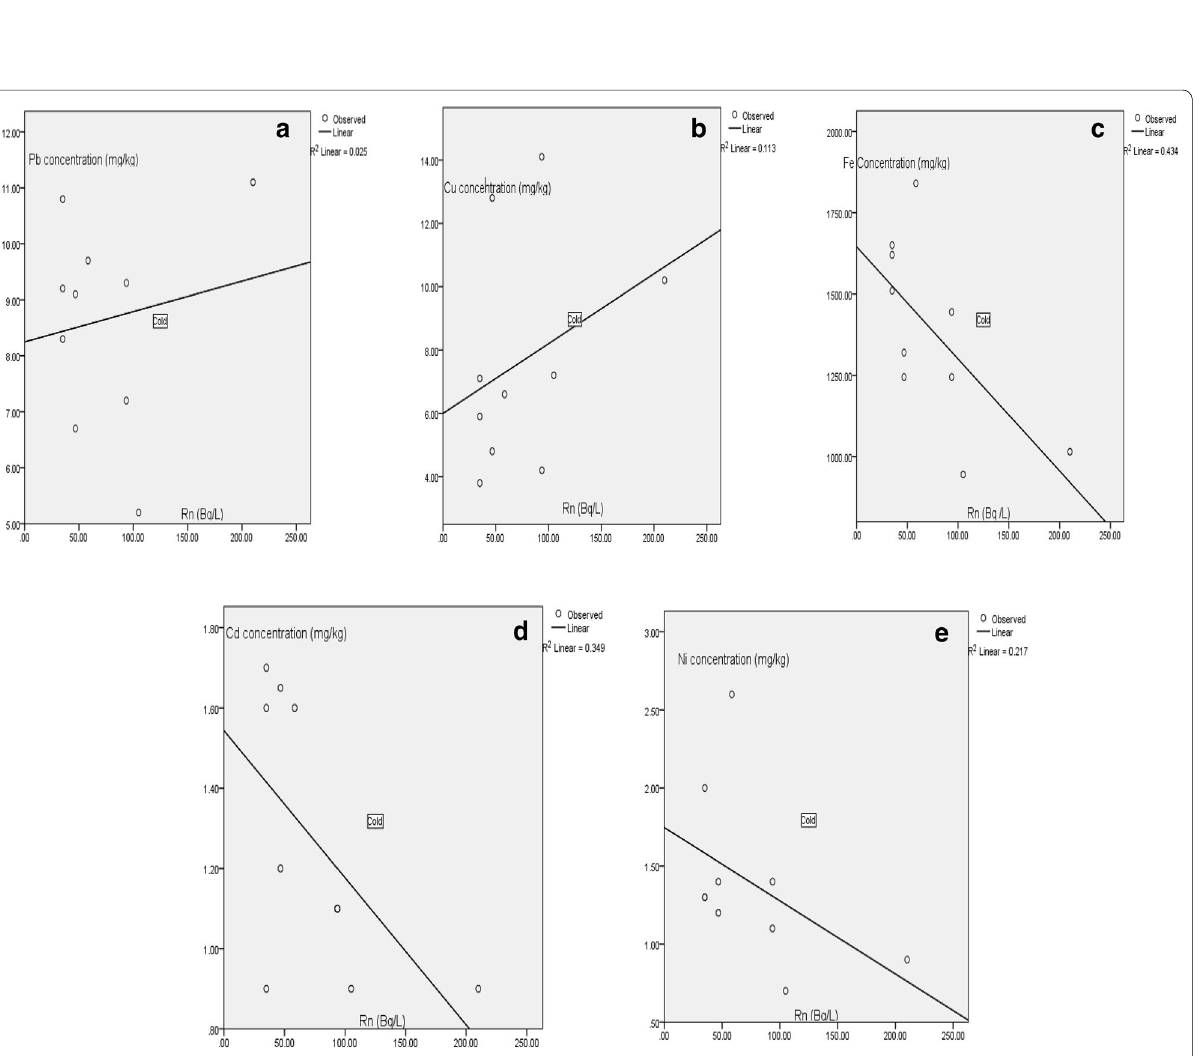
Fig. 3 a Pb vs Rn. b Cu vs Rn. c Fe vs Rn. d Cd vs Rn. e Ni vs